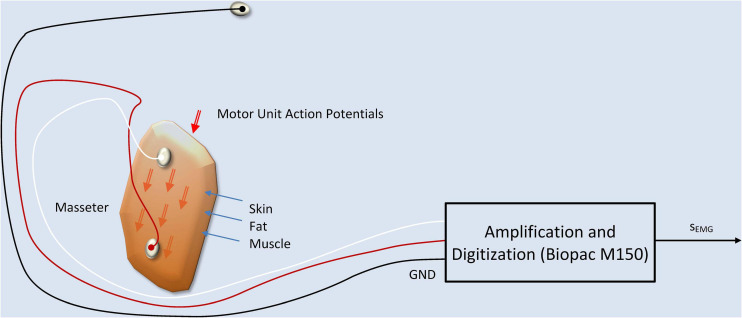
sEMG production and recording model. The two active electrodes are fixed at both ends of the masseter muscle, on the skin, capturing a signal which is the additive composition of the Motor Unit Action Potentials (MUAPs) traveling along the muscle fibers. A ground electrode fixed at the forehead serves as a reference point. The equipment used in the recordings is a WiFi-connected electrode terminal unit which communicates the signals on a wireless link to a Biopac M150 recording system.